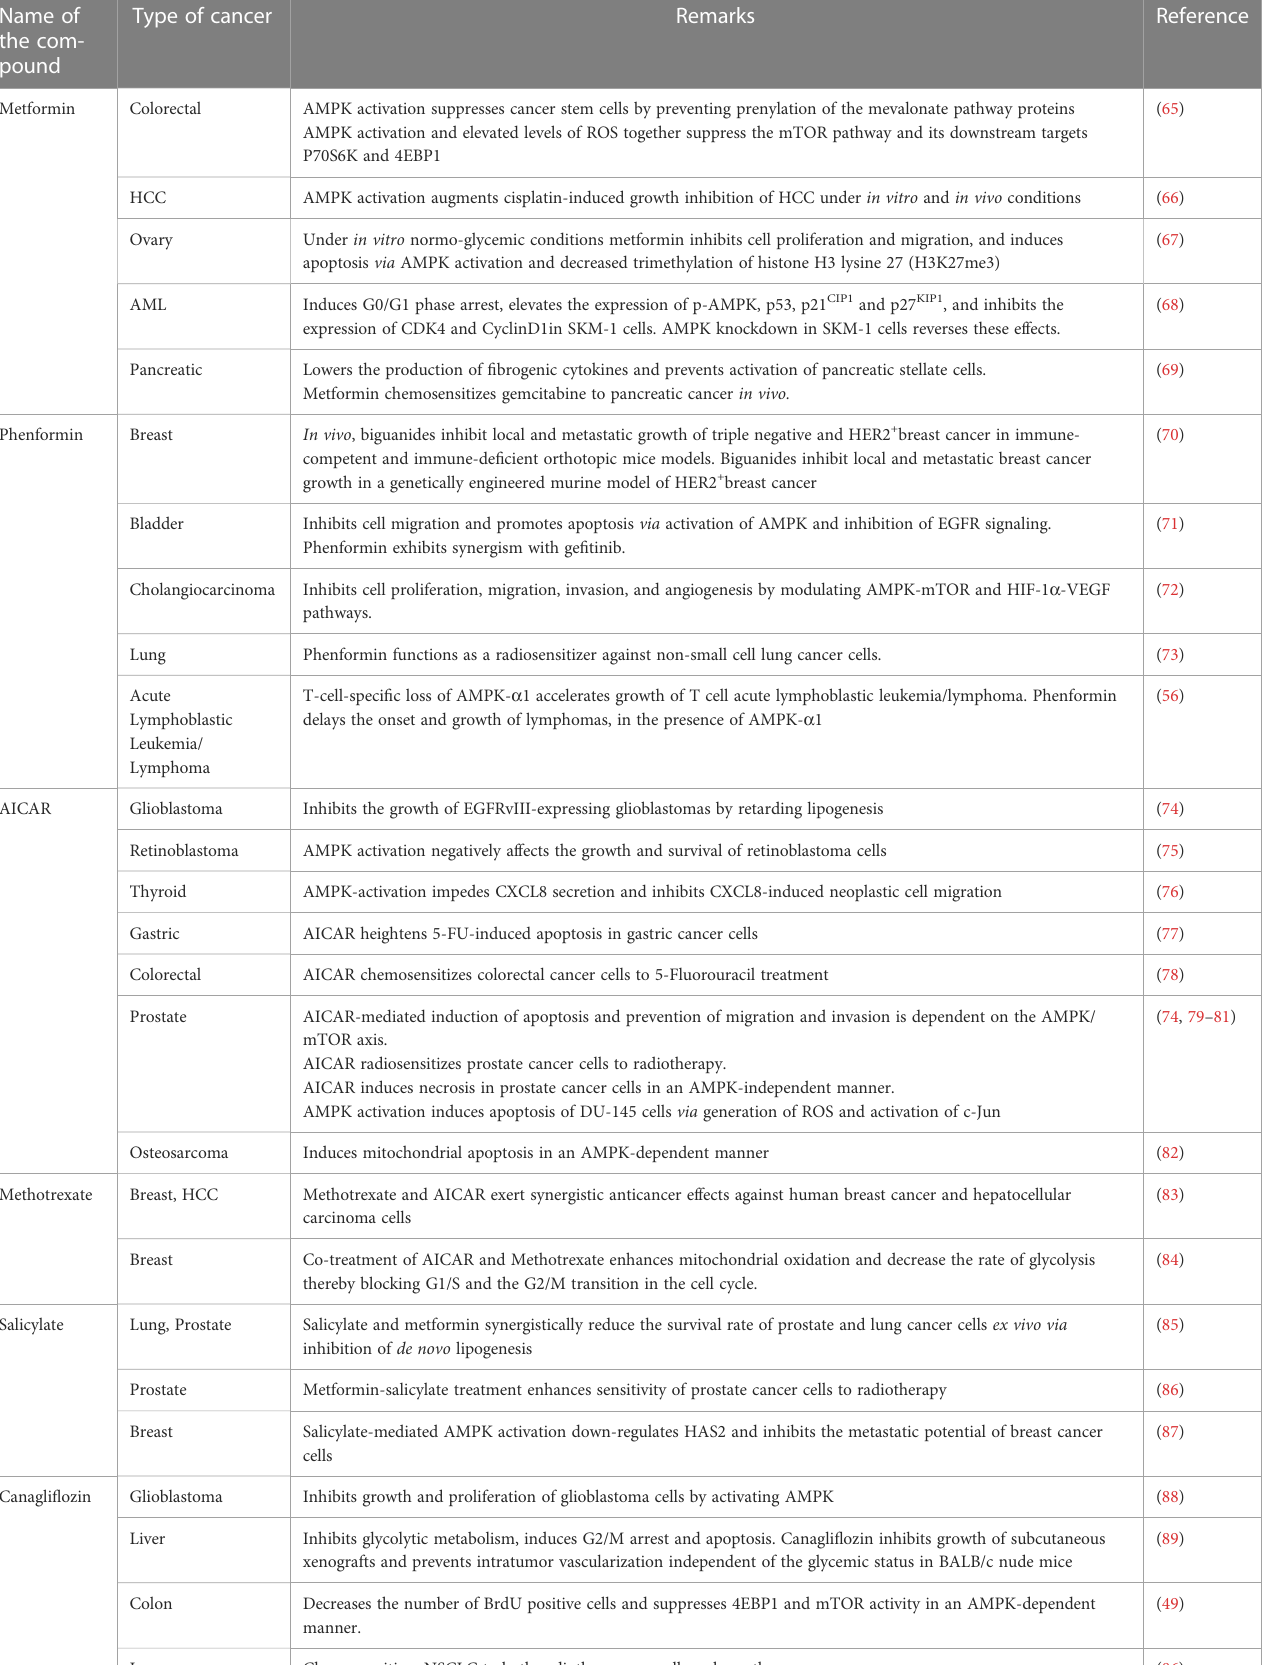
TABLE 1 Pre-clinical evidences of the anti-cancer effects of pharmacological activation of AMPK. Name of the